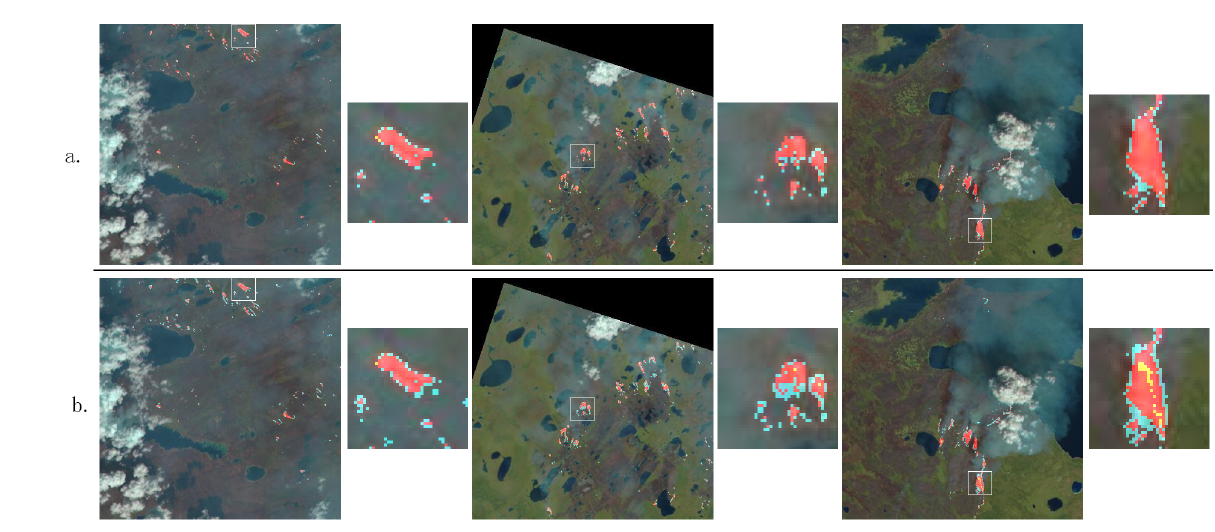
Figure 8. The visualized comparison of two models. Subfigure a. shows the prediction of our ANN model and subfigure b. shows the results of the fixed threshold model. Red pixels stand for true positive, yellow pixels stand for false negative, cyan pixels stand for false positive, and the rest of pixels are true negative.